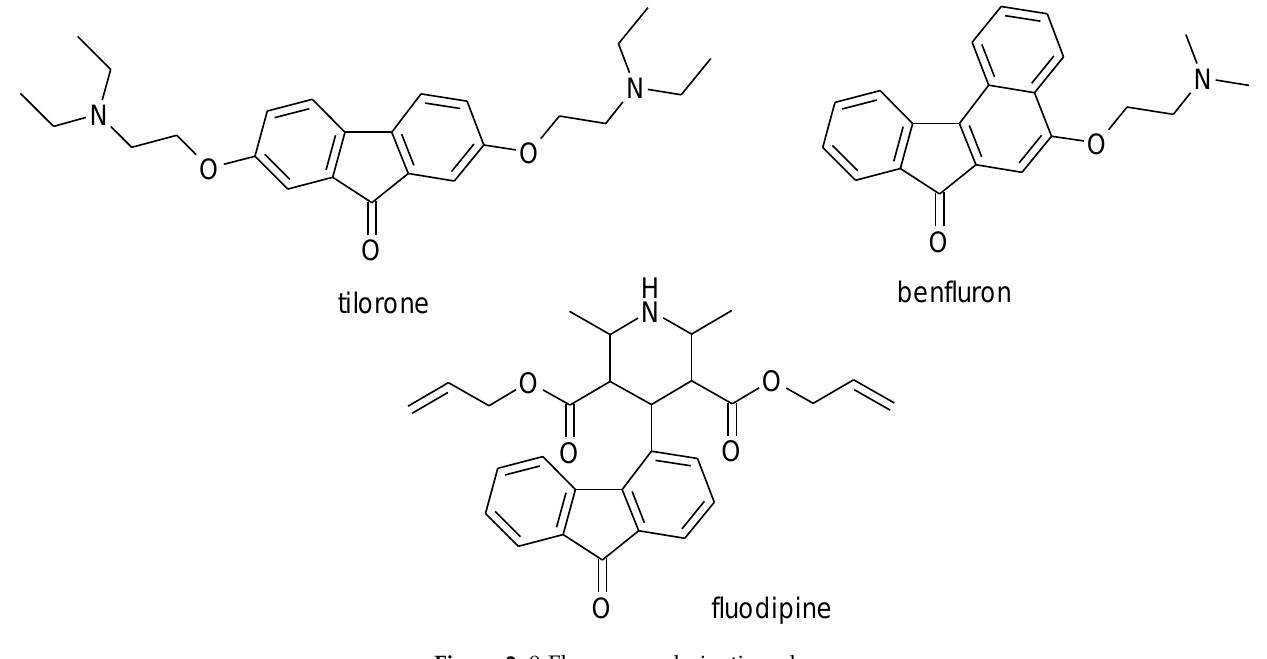
Figure 2. 9-Fluorenone derivatives drugs.